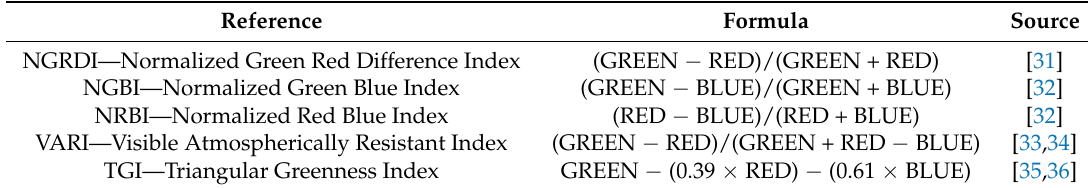
Table 1. Vegetation indices computed from median luminescence value normalized by brightness. Reference Formula Source NGRDI—Normalized Green Red Difference Index (GREEN − RED)/(GREEN + RED) [31] NGBI—Normalized Green Blue Index (GREEN − BLUE)/(GREEN + BLUE) [32] NRBI—Normalized Red Blue Index (RED − BLUE)/(RED + BLUE) [32] VARI—Visible Atmospherically Resistant Index (GREEN − RED)/(GREEN + RED − BLUE) [33,34] TGI—Triangular Greenness Index GREEN − (0.39 × RED) − (0.61 × BLUE)